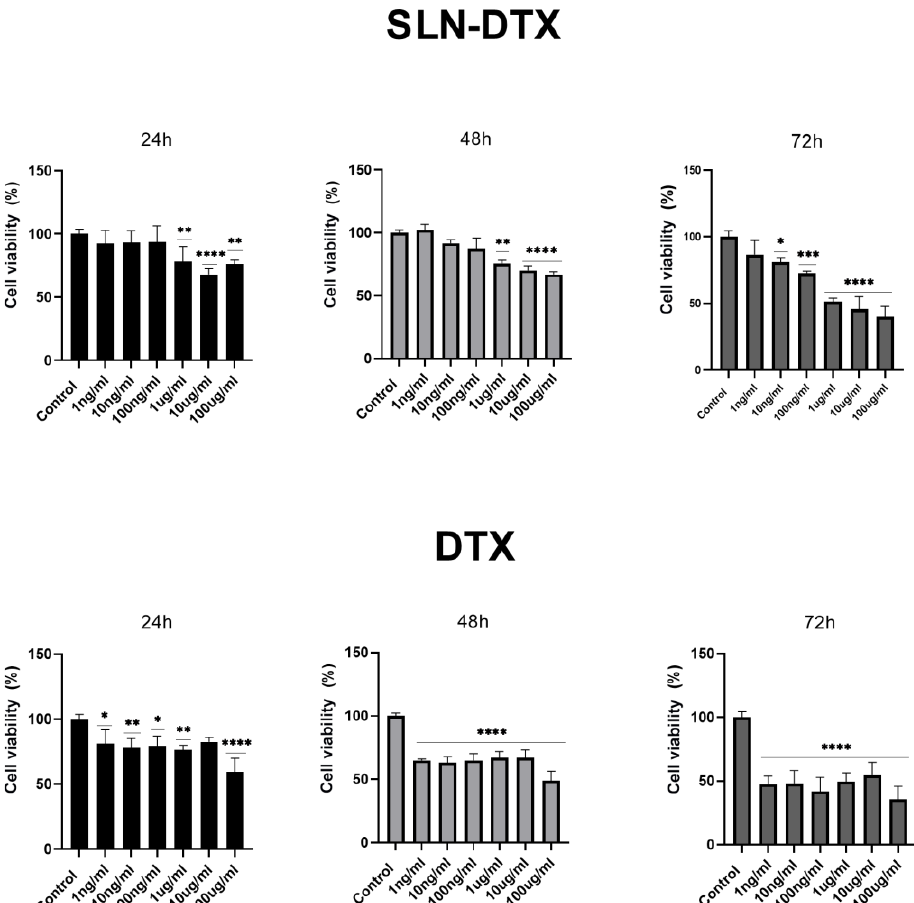
Figure 1. Cell viability analysis of MDA-MB-231 by MTT treated with DTX and SLN-DTX, after 24 h, 48 h, and 72 h. The data represent the mean ± SEM of three independent experiments in triplicate. * p < 0.05, ** p < 0.01, *** p < 0.001 **** p < 0.0001 compared to the untreated control.